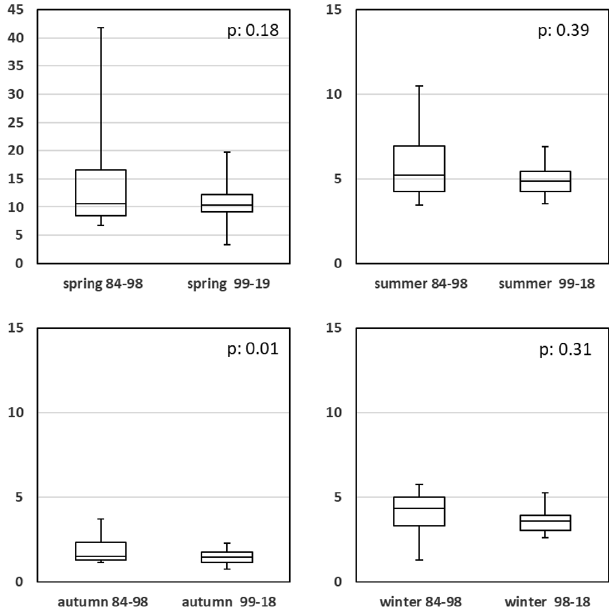
Figure 8. Seasonal comparison of chlorophyll a concentration (µgL − 1 ) for high and low eutrophication